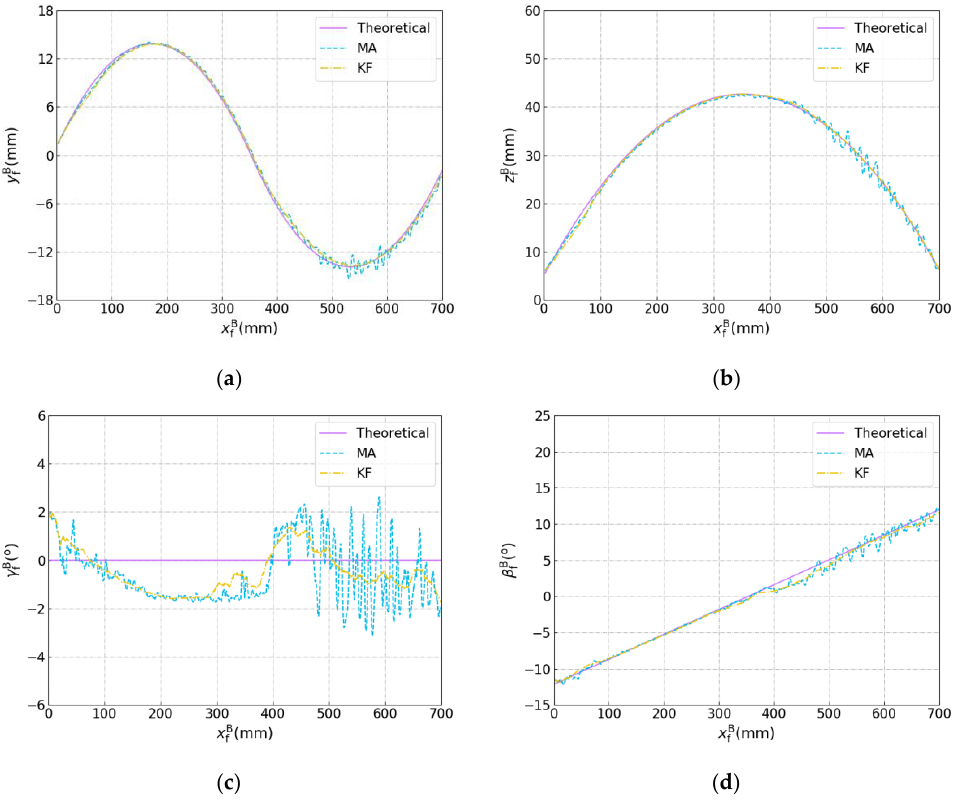
Figure 19. Results of the seam tracking experiment with the curved workpieces. ( a ) 𝑦 fB versus 𝑥 fB . ( b ) 𝑧 fB versus 𝑥 fB . ( c ) 𝛾 fB versus 𝑥 fB . ( d ) 𝛽 fB versus 𝑥 fB .